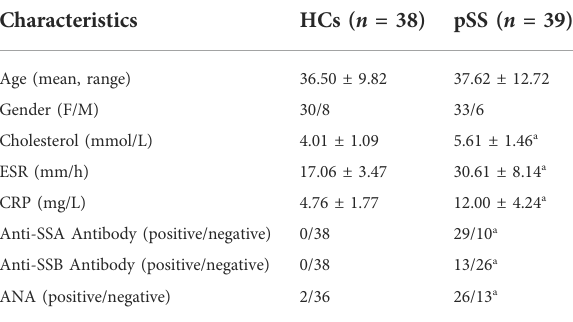
TABLE 1 Demographics and clinical characteristics of pSS and